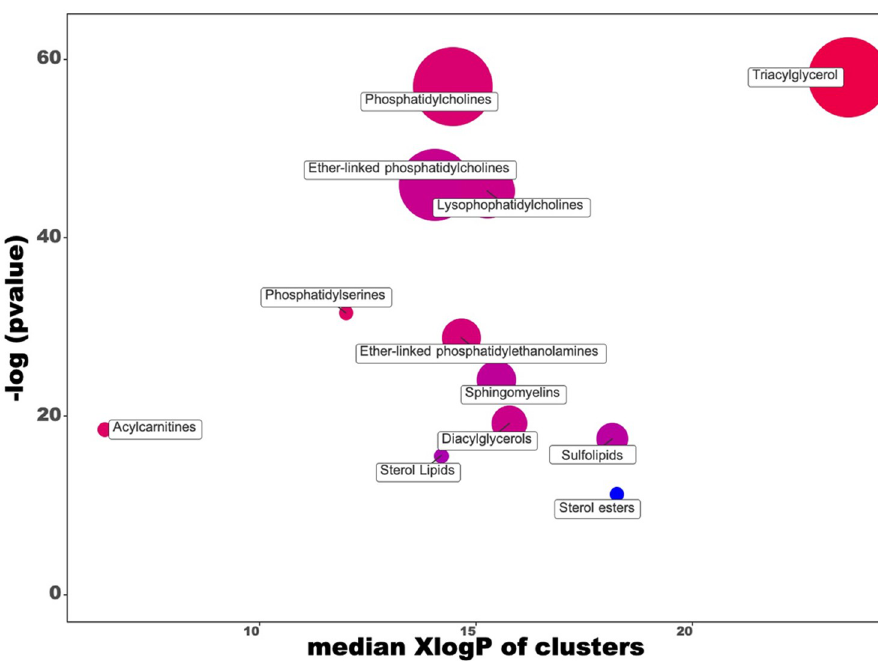
Fig 2. ChemRICH set enrichment statistics plot built considering the compounds significantly discriminating the comparison L+P vs CTRL diets. Each node reflects a significantly altered cluster of metabolites. Enrichment p -values are given by the Kolmogorov–Smirnov test. Node sizes represent the total number of metabolites in each cluster set. The node color scale shows the proportion of increased (red) or decreased (blue) compounds in L+P-diet compared to CTRL. Purple-color nodes have both increased and decreased